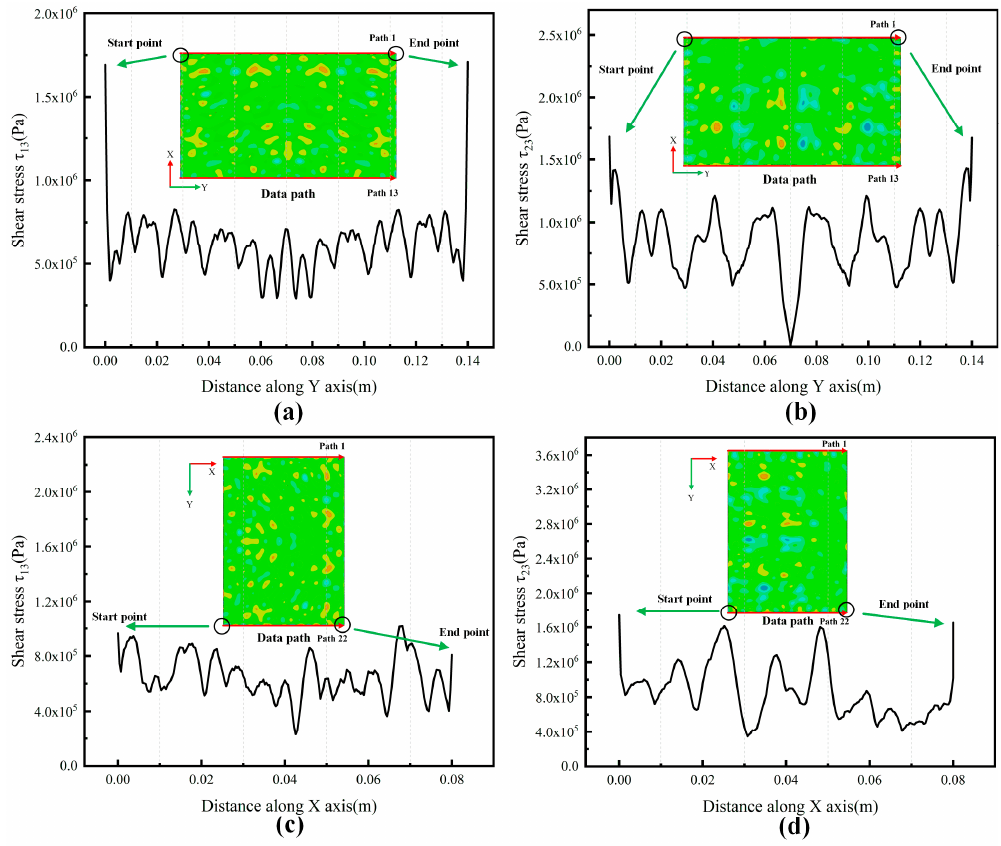
Figure 11. Average shear stress amplitude varies along the axis direction: ( a ) τ 13 amplitude varies along the Y axis; ( b ) τ 23 amplitude varies along the Y axis; ( c ) τ 13 amplitude varies along the X axis; ( d ) τ 23 amplitude varies along the X axis.